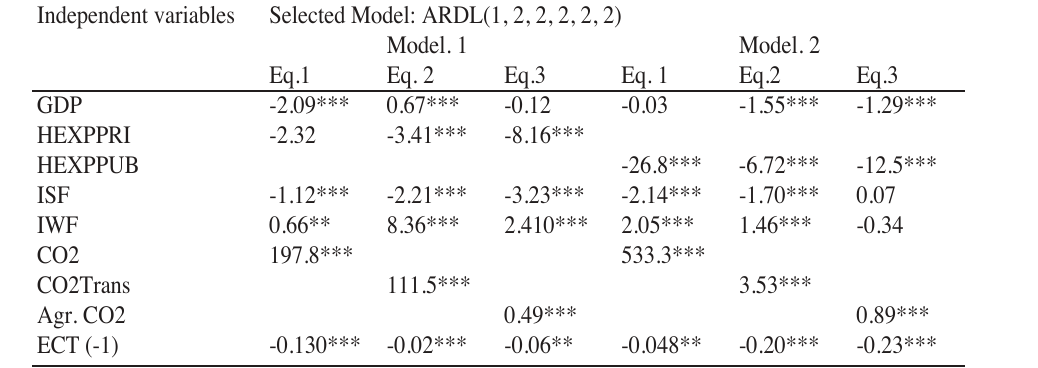
Table 5. Panel ARDL: Long Run Results (Dependent Variable: Child Mortality) Independent variables Selected Model: ARDL(1, 2, 2, 2, 2, 2)